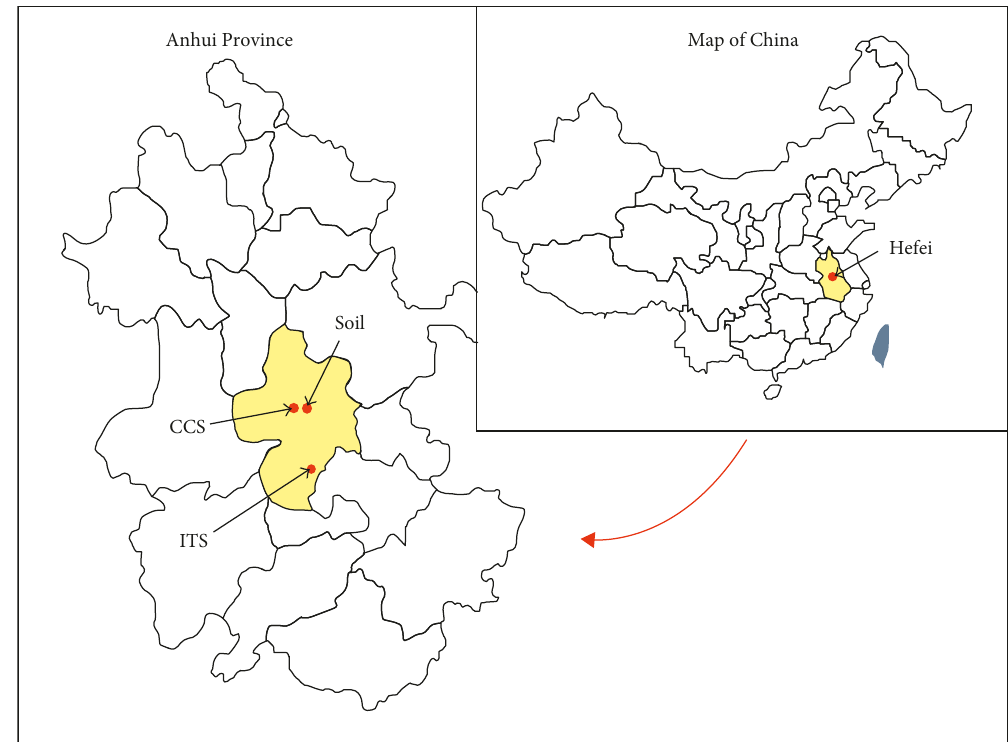
Figure 1: Sampling sites of the tested materials. Table 1: Basic physical properties of the tested soils.